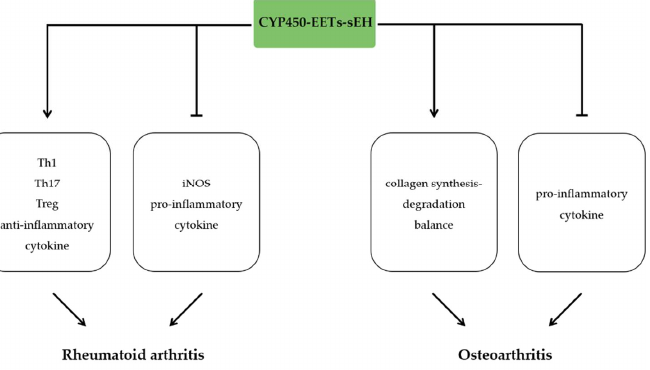
Figure 10. The anti-inflammatory effects of EETs in arthritis. EETs ameliorate rheumatoid arthritis by increasing Th1, Th17, Treg, and anti-inflammatory cytokines and reducing iNOS and pro-inflam- matory cytokines. EETs ameliorate osteoarthritis by promoting collagen synthesis-degradation bal- ance and reducing pro-inflammatory